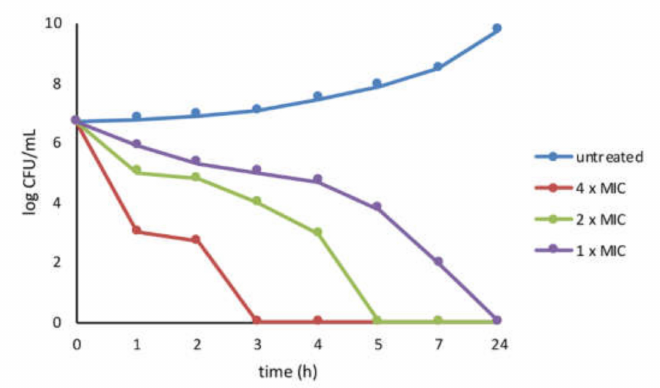
Figure 4. Killing kinetics for S. aureus following treatment with the PYED-1. Growth kinetics were monitored following exposure to PYED-1 at 1 x MIC, 2 x MIC, and 4 x